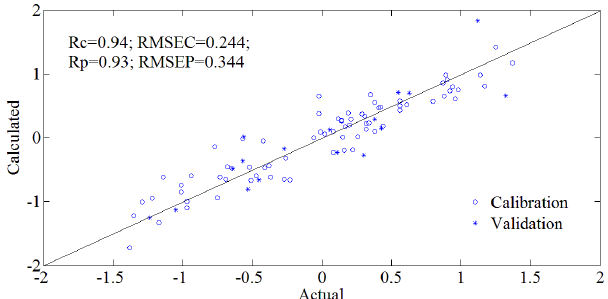
Fig. 11. The quantitative model of calibration and validation sets on the comprehensive indicator.